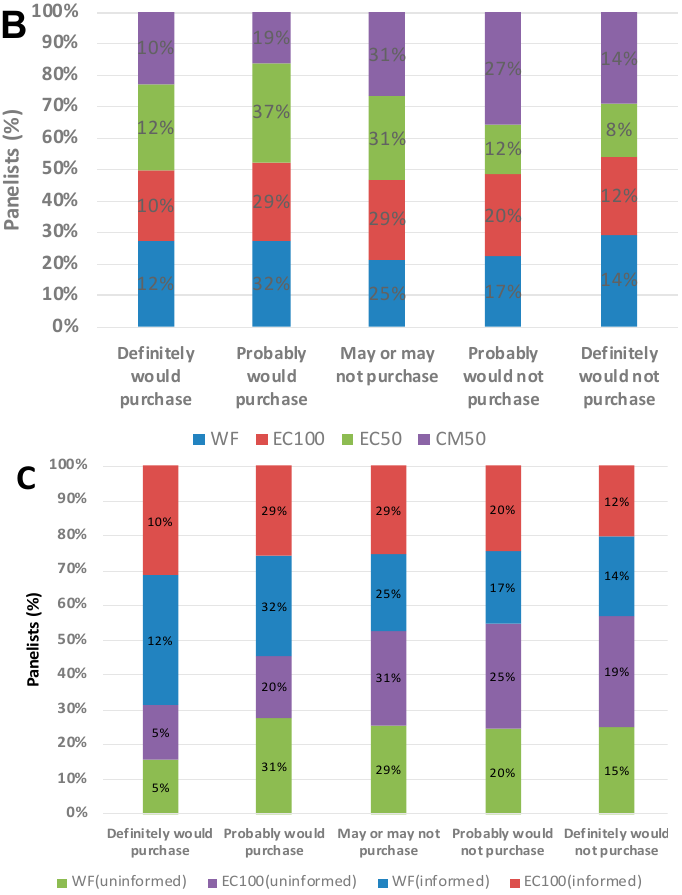
Figure 9. Purchase intent of whole wheat flour (WF) roti (Indian flat bread) samples fortified with encapsulated defatted Nannochloropsis oceanica (EC) and color ‐ masked defatted Nannochloropsis oceanica (CM) at day 0, ( A ) pre ‐ claim, ( B ) post ‐ claim and ( C ) comparison between WF and EC100; n = 58.